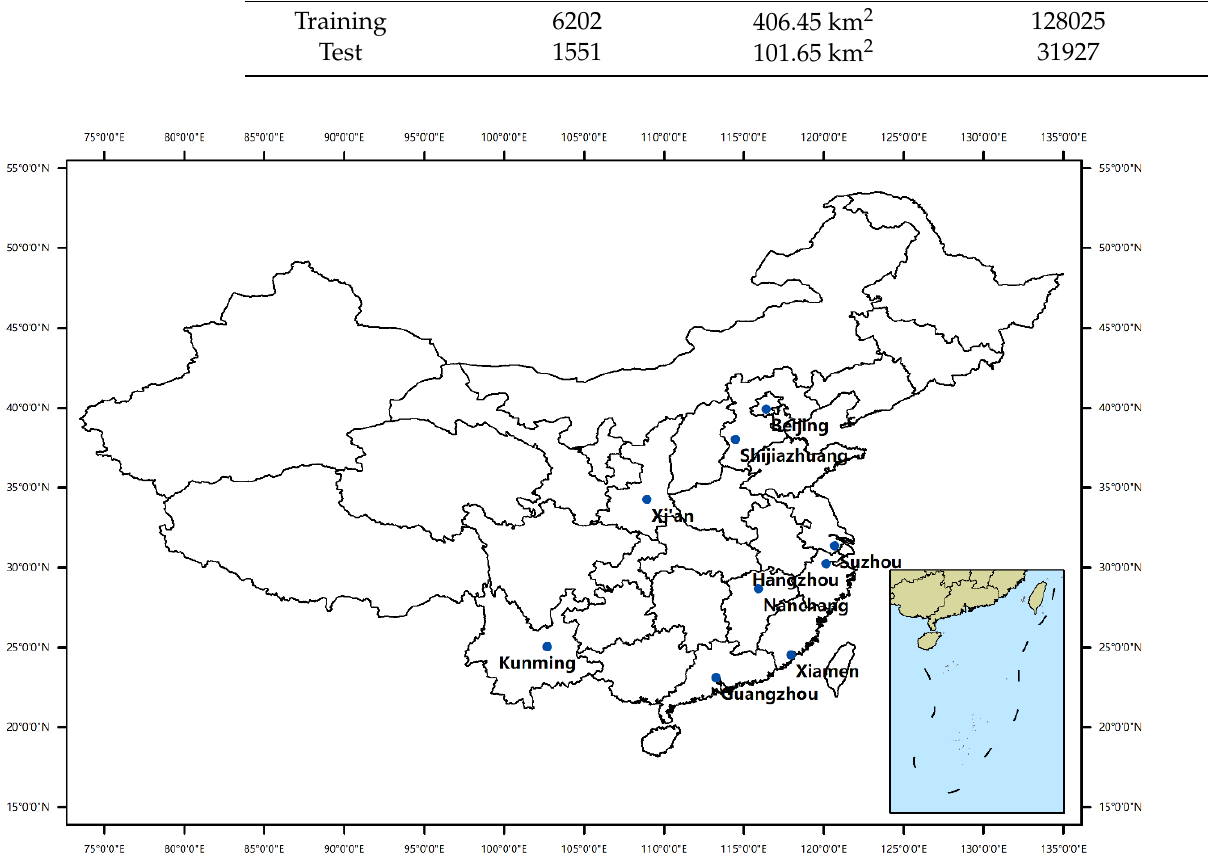
Figure 5. The geographical distribution of images in the dataset. This figure is from [3].